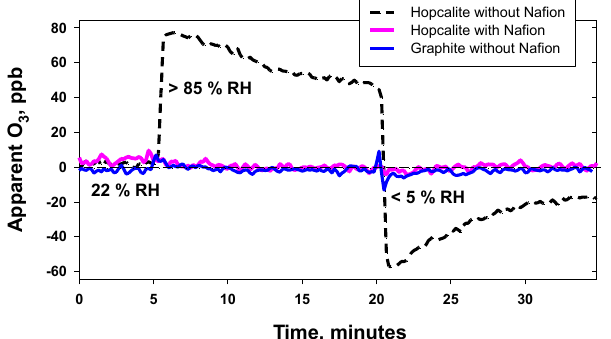
Figure 4. Time series showing the response of a Model 202 ozone analyzer to changes in relative humidity with no ozone present and different